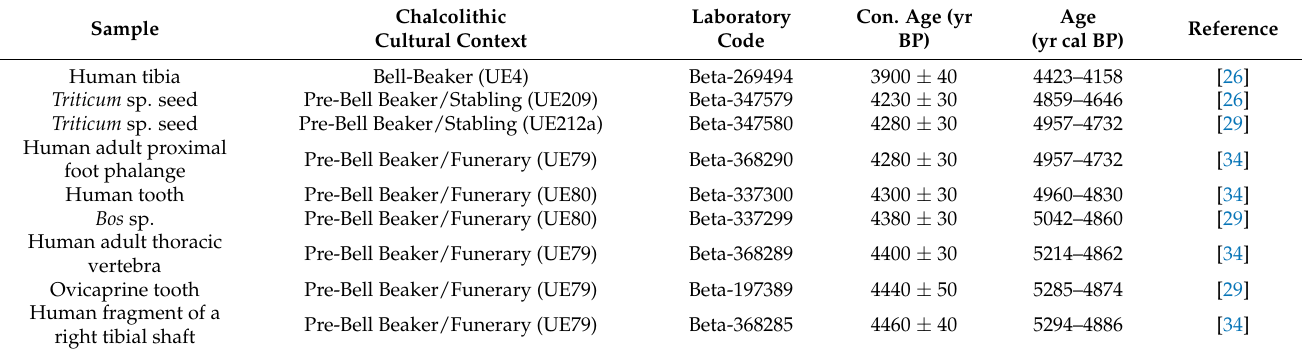
Table 1. Radiocarbon dates of the Chalcolithic levels of El Portal ó n de Cueva Mayor sites. Con., conventional; cal, calibrated.